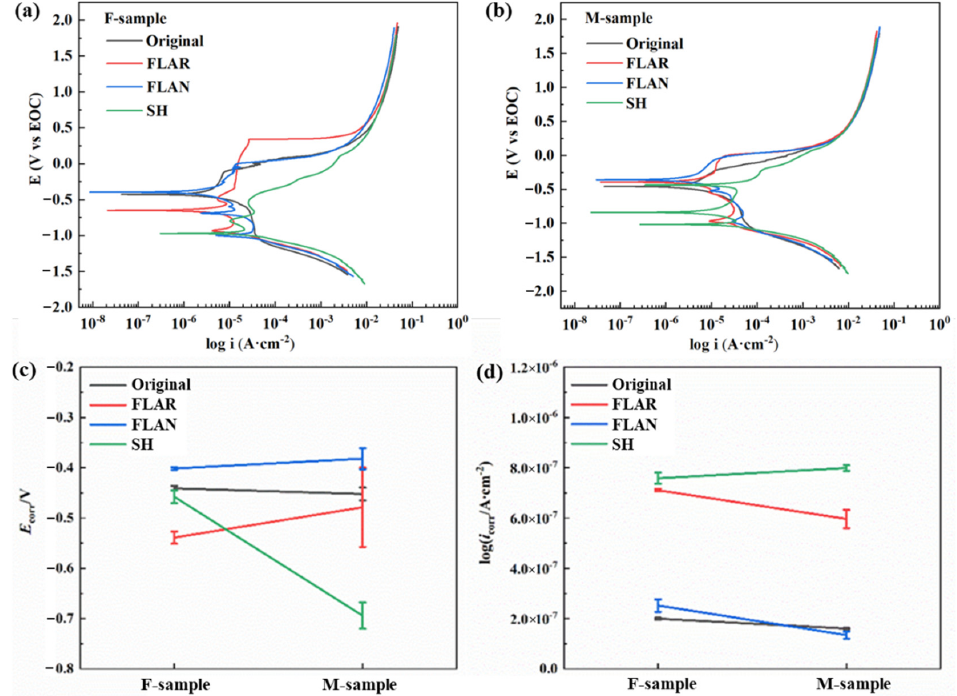
Figure 5. Potentiodynamic polarization curves of the ( a ) F-samples and ( b ) M-samples. ( c ) Corrosion voltages and ( d ) corrosion currents of SLM-ed samples with different post-treatment processes. Table 4. Quantitative information about the potentiodynamic polarization curves of 8 samples in 0.5 mol/L NaCl solution.